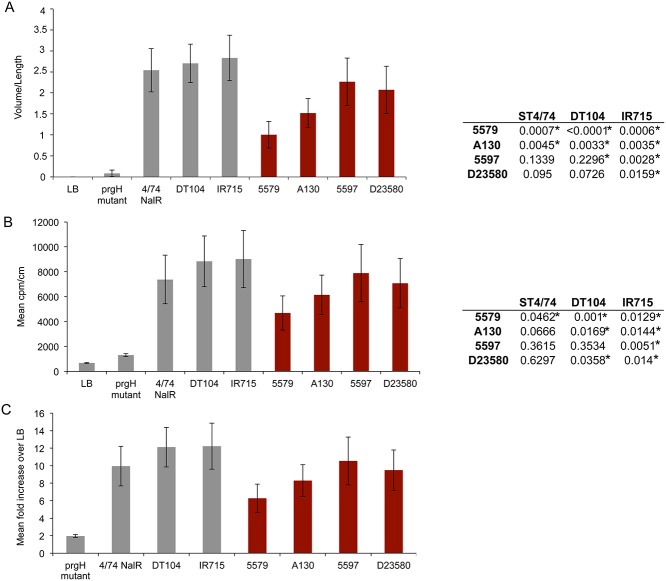
Secretory and inflammatory responses induced by ST19 (grey bars) and ST313 S. Typhimurium strains (maroon bars) in bovine ligated ileal loops.
A. Mean fluid accumulation normalised to loop length [volume (mL)/length (cm)]. B. Influx of 111In-labelled PMN for test strains normalized to loop length and negative control loops, as described in Methods. Values represent the mean ± SEM of triplicate determinations in two independent calves. Right panel of A and B shows summary of paired T-test results. Asterisks show statistically significant pairwise comparisons. C. Influx of 111Indium oxinate-labelled polymorphonuclear leukocytes (PMN) induced by ST313 isolates relative to the negative control.